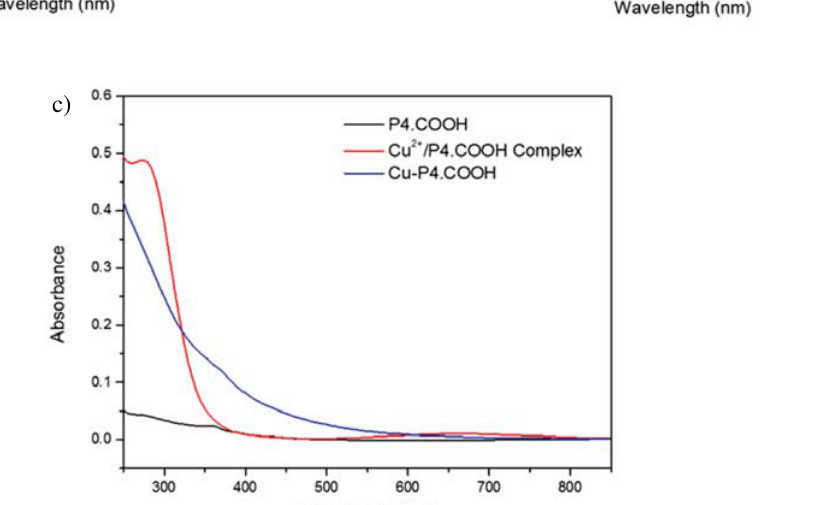
Ertürk et al.: Preparation of Cu Nanocomposites from EDA, DETA, ...